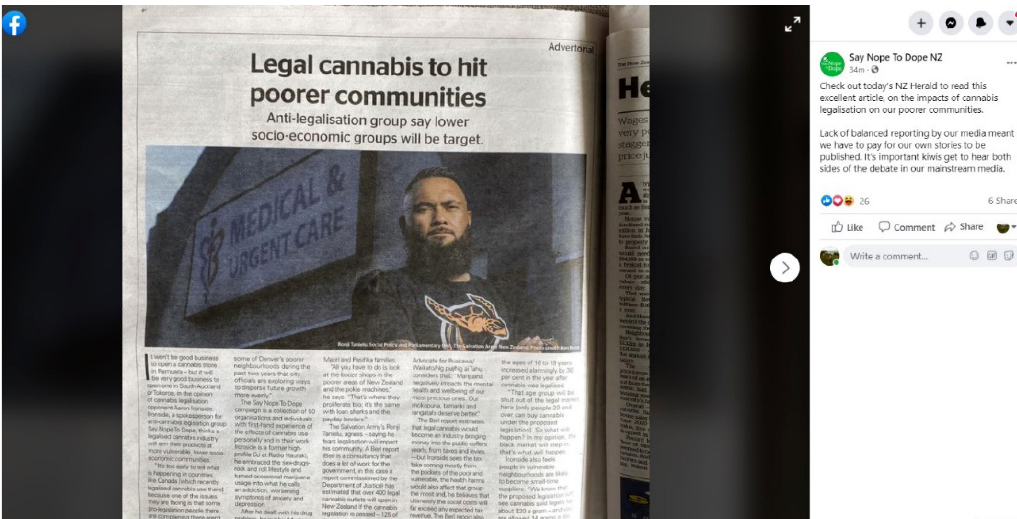
Figure 4. Sponsored article in a national newspaper, shared by the anti‐legalisation Facebook campaigner account. Note: Facebook post reads, “Lack of balanced reporting by our media meant we have to pay for our own stories to be published. It’s important that kiwis get to hear both sides of the debate in our mainstream